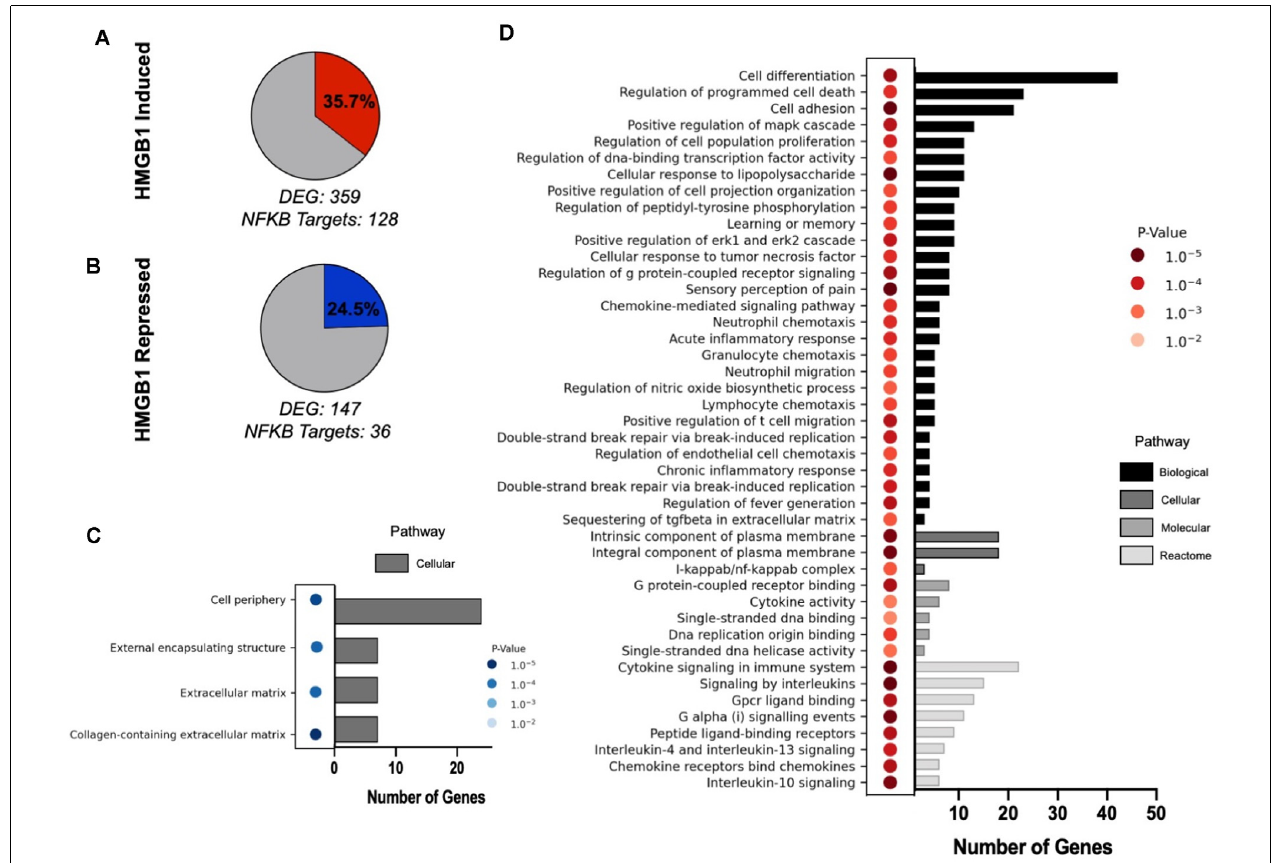
FIGURE 6 | Gene ontology enrichment analysis of HMGB1 regulated NF κ B gene pathways. Analysis of HMGB1 regulated transcriptional responses in OPCs identified differentially expressed NF κ B target genes which reflected both induced (A) and repressed (B) patterns of gene expression. (C) GO analysis of repressed cellular processes in OPCs treated with HMGB1 as defined by NF κ B-regulated transcriptional targets. No pathways in this analysis other than those listed had significant differences from control. (D) GO analysis of processes induced by HMGB1 identified biological pathways which emphasized cellular periphery as a major influence of HMGB1 on OPC activity. These data confirm the pathophysiological actions of HMGB1 in vitro and in vivo and provide a template for understanding of how HMGB1 potently affects OPC differentiation potential. P values depicted in (C and D) are indicated by color and the number of genes in each pathway category are indicated by a bar graph on the X axis for each